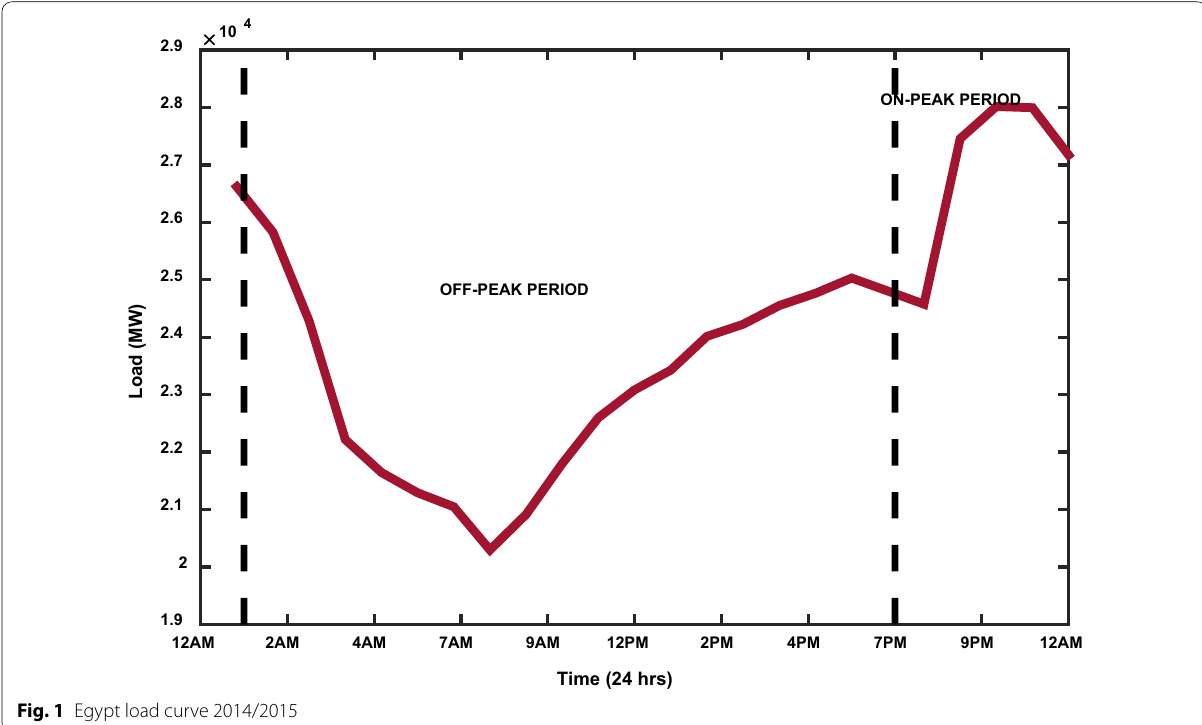
Fig. 1 Egypt load curve